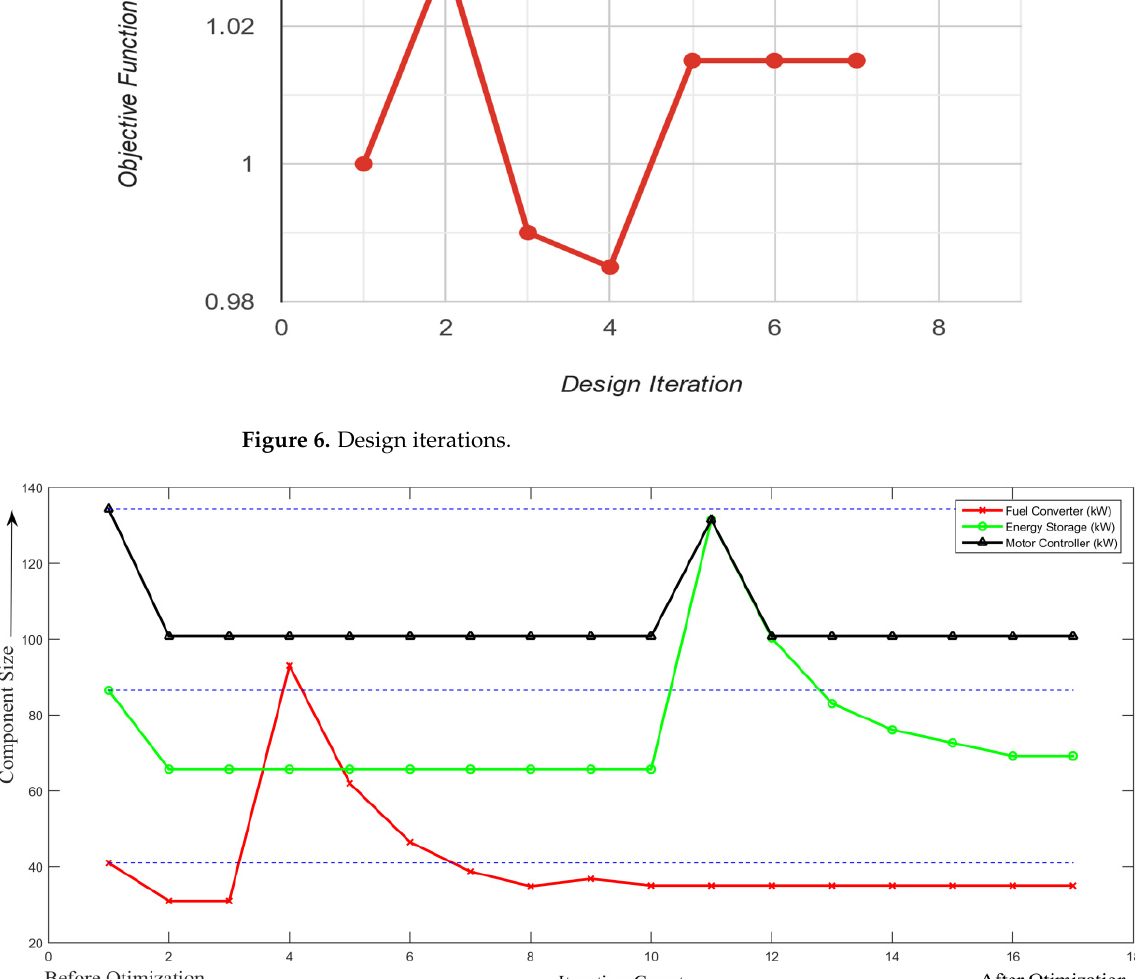
Figure 7. Design variable before and after optimization.